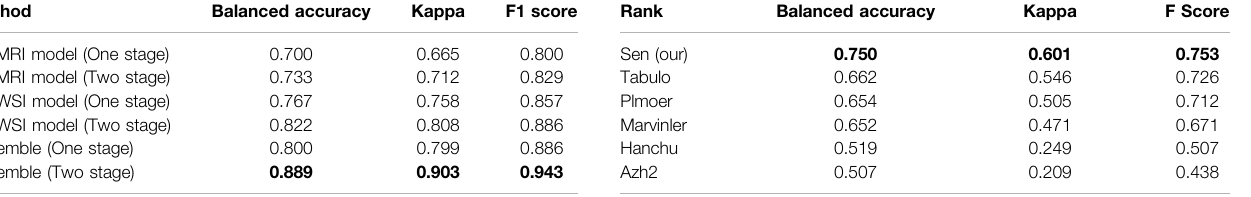
TABLE 1 | Ablation experiment results on CPM-RadPath 2020 validation data. Method